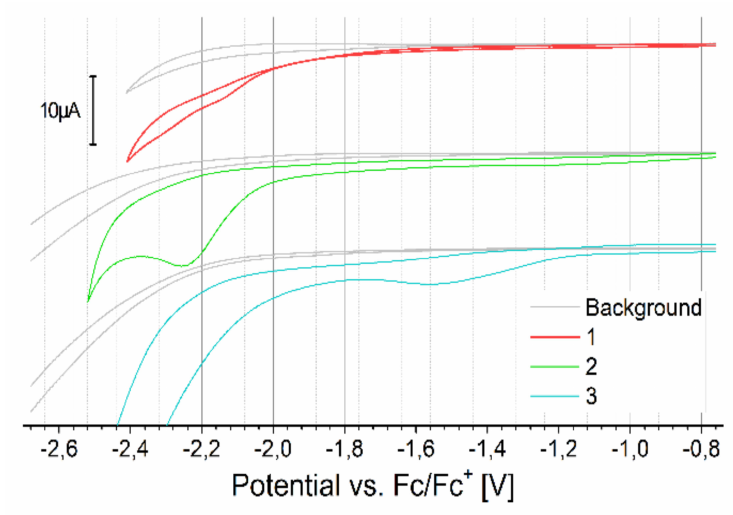
Figure 5. The CV of reduction of monomers versus ferrocene redox couple, concentration 2 mmol / dm 3 in dichlorometane (DCM), 100 mV / s.